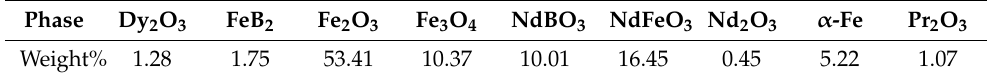
Table 4. XRD analysis of oxidized NdFeB